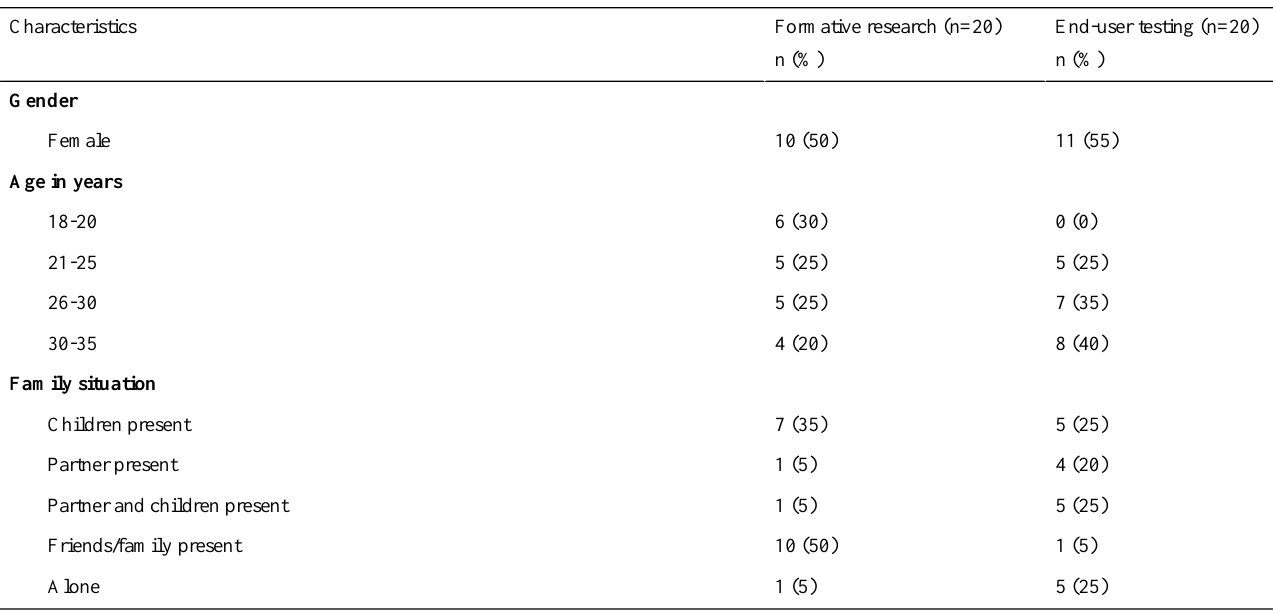
Table 1. Participant